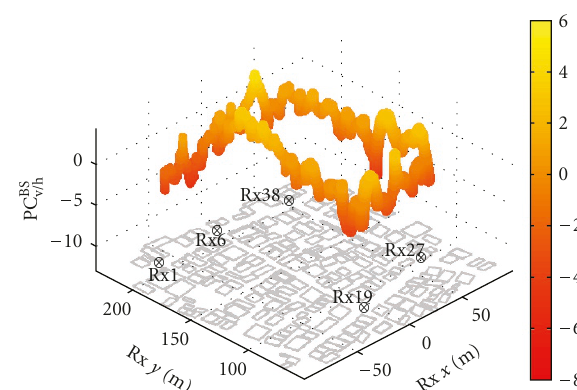
of the SCs Δ s = 20 (ca 3m). v